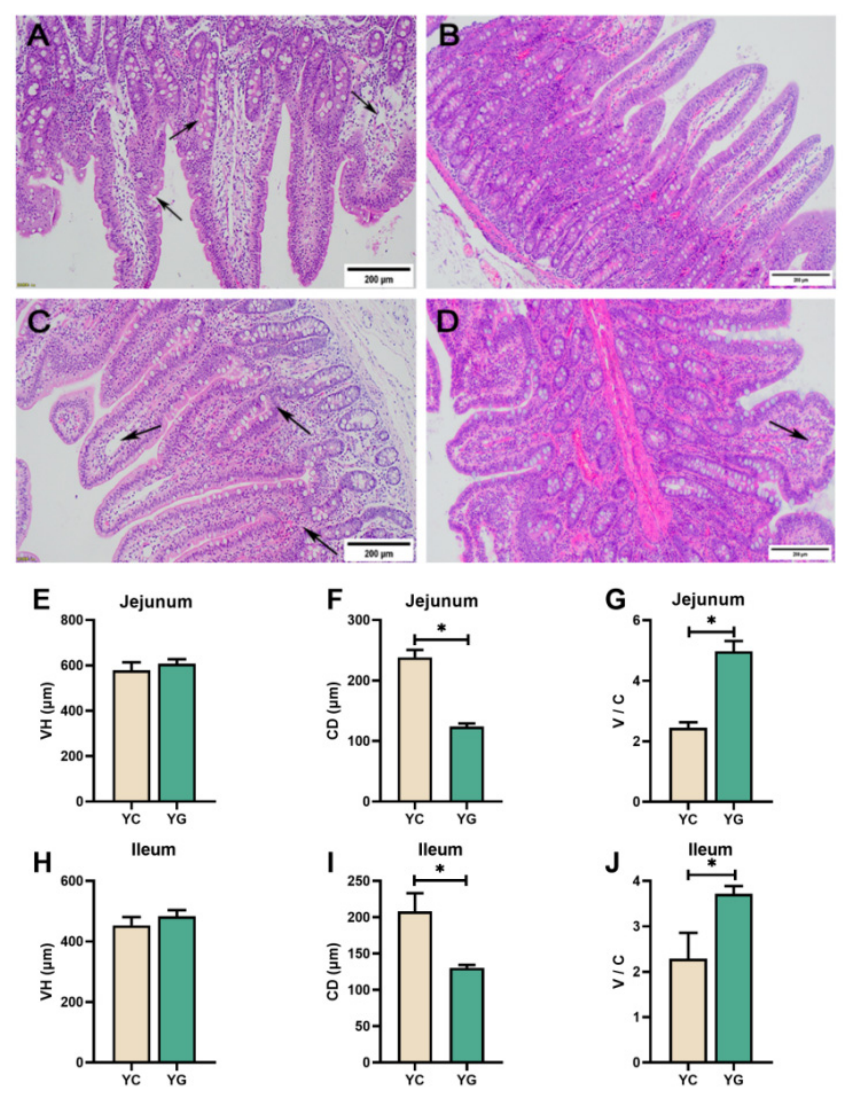
Figure 6. Effect of glucose-supplemented diet on jejunal and ileal slices of pigs under chronic cold stress. ( A ) In the YC group, there was a decrease in cupped cells in the jejunal mucosa and a goblet crypt with mucosal edema. ( B ) No significant abnormalities were seen in the jejunal mucosa of the YG group. ( C ) Local inflammatory cell infiltration, mucosal edema, and crypt enlargement in the ileal mucosa of the YC group. ( D ) No obvious impairment of ileal mucosa in the YG group. ( E – G ) VH, CD, and V/C in jejunum of the YC group. ( H – J ) VH, CD, and V/C in ileum of the YG group. Black arrows indicate abnormal mucosal development. Data are presented as the means ± SEM. * p < 0.05. Compared with the YC group, there were no changes in the plasma D-lactate content and the sIgA levels in the jejunal and ileal mucosa of the YG group, and the tight junction proteins (ZO-1, Occludin and claudin-1), pyroptosis, and apoptosis-related gene mRNA expression levels had no significant changes ( p > 0.05, Figure 7). Notably, we found that the mRNA and protein expression of TLR4 and MyD88 in jejunum mucosa in the YG group were down-regulated compared with the YC group ( p < 0.05, Figure 7D,G). Subsequently, it was found that the mRNA expression of IL-6 and IFN- γ in jejunal mucosa of the YG group was also lower than that of the YC group ( p < 0.05, Figure